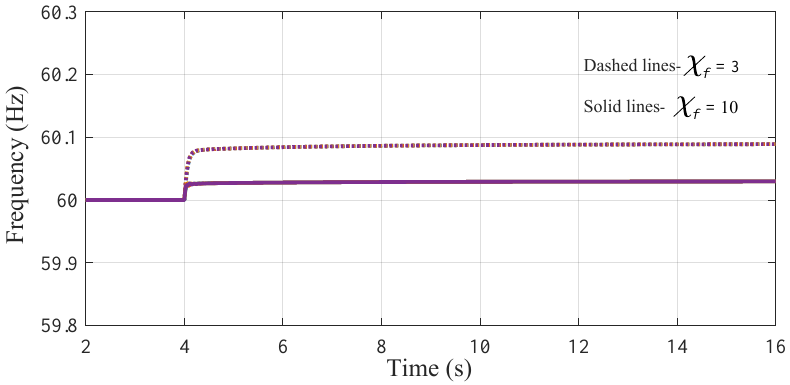
Figure 7. Comparative frequency performance under unbounded actuator attacks with different adaptive tuning parameters.